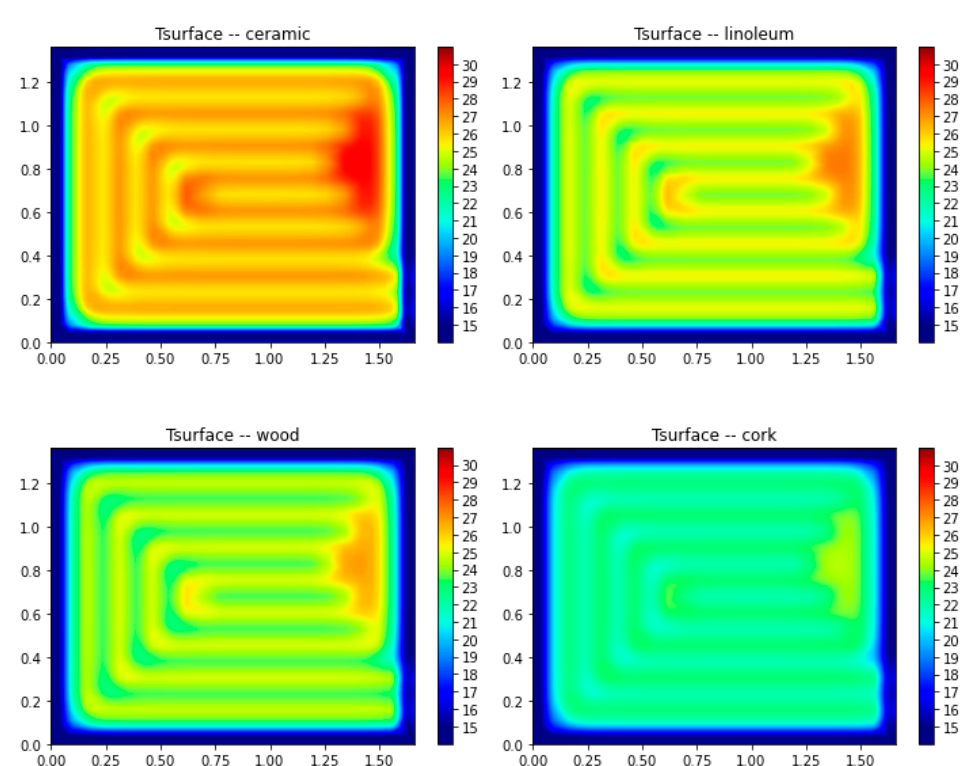
Figure 9. Temperature distribution in the surface of the slab considering different finishing materials (results in degrees Celsius).